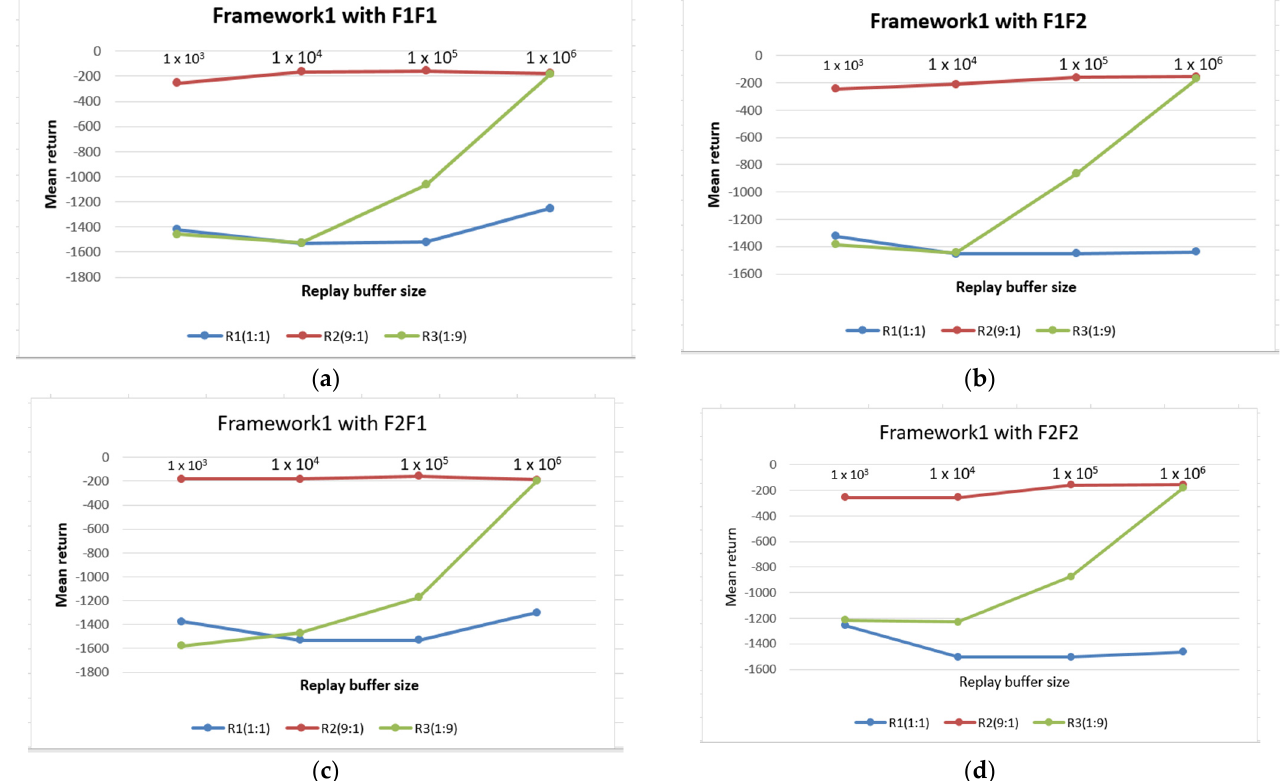
Figure 5. Performance of Framework 2 across multiple buffer sizes, retention strategies, and sampling ratios. ( a ) Framework 1 is evaluated using the FIFO for both replay buffers; ( b ) Framework 1 is evaluated using FIFO for the first replay buffer and enhanced FIFO for the second replay buffer; ( c ) Framework 1 is evaluated using enhanced FIFO and FIFO for the first and second replay buffers, respectively; ( d ) Framework 1 is evaluated using enhanced FIFO for both replay buffers. Table 4. List of major notations.